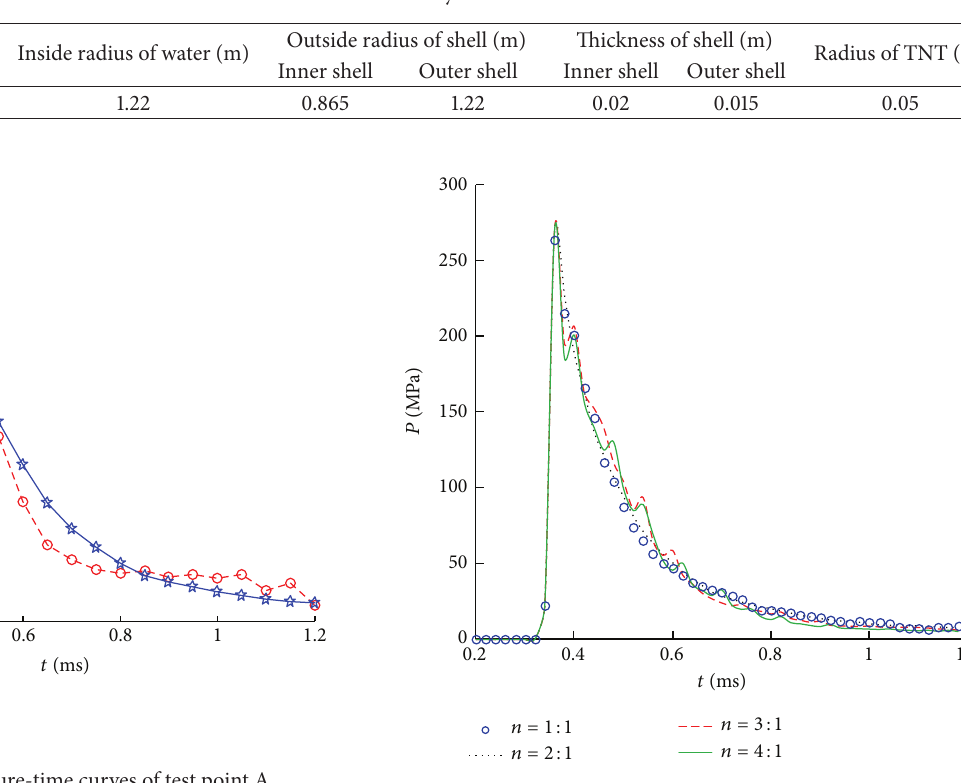
Table 9: Parameters of double cylindrical shell.